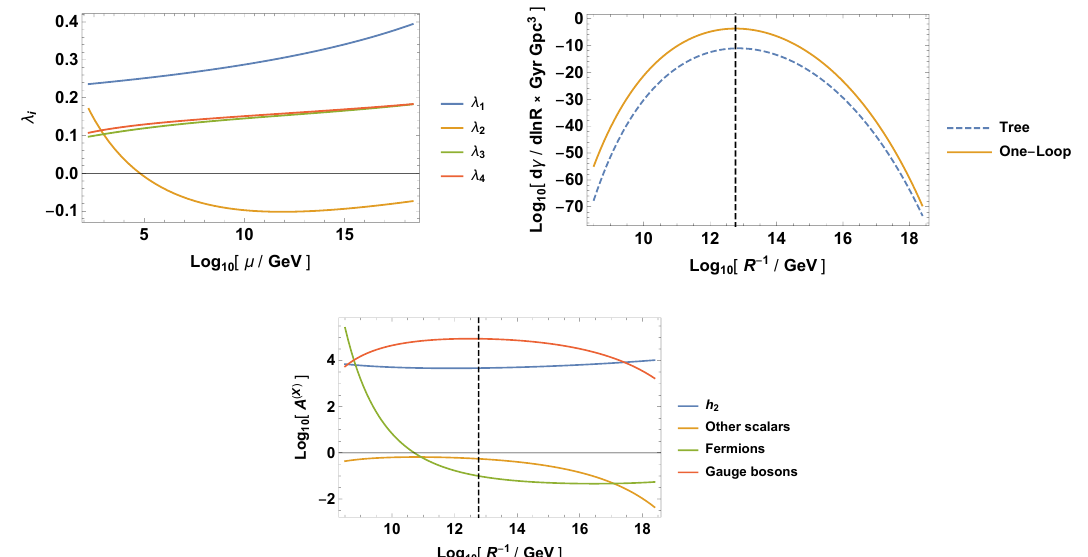
Figure 1 . An example of the calculation of a vacuum decay rate. The top left panel shows the RG evolution of the Higgs quartic couplings. The top right panel shows the di(cid:11)erential vacuum decay rates with and without the calculation of A . The bottom panel shows each quantum correction to the di(cid:11)erential vacuum decay rate. The vertical black dashed line indicates the maximum of the di(cid:11)erential vacuum decay